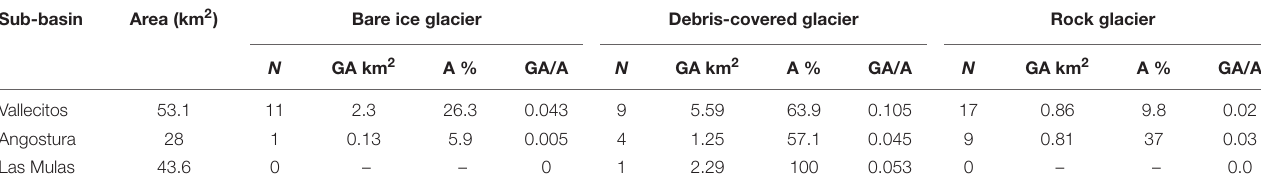
FIGURE 9 | Source area. (a) Picture of Plata peak showing predomination of ice covered glacier and debris rock glaciers in the southern sector of the headwater of the Angostura Valley where rock avalanche remains are lacking. (b) Google 3D stereographic view of the Plata peak without glaciers in the southern sector. TABLE 3 | Areas occupied by different types of glaciers in the main sub-basins of the Blanco River basin. Area (km 2 ) Bare ice